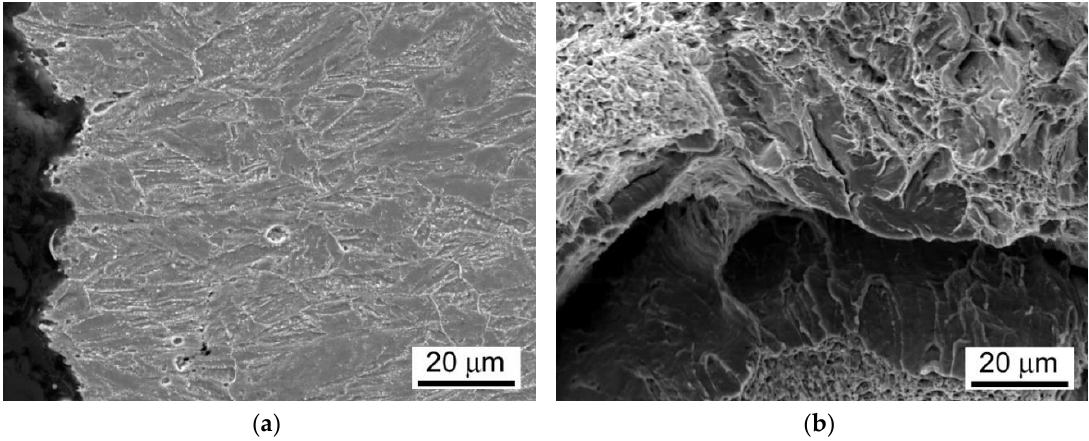
Figure 15. Fracture analysis of hydrogen-free T92/T92 weldment initially processed by the PWHT-2 and subsequently ruptured in WM after the room-temperature tensile test: ( a ) fracture path and microstructure beneath the fracture; ( b ) fracture surface showing mixed fracture consisting of both ductile dimple tearing and transgranular quasi-cleavage.